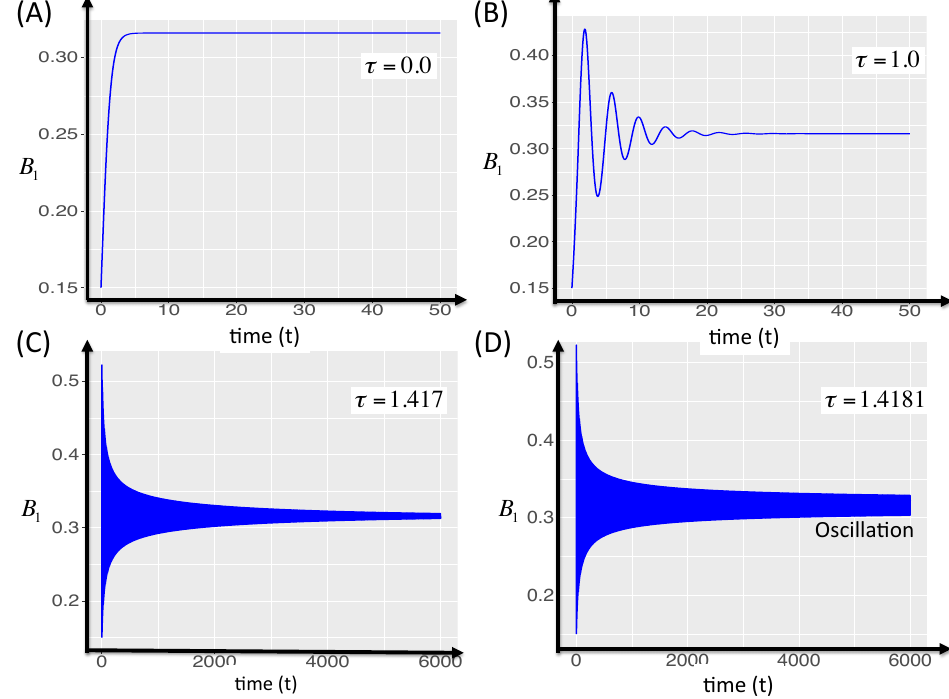
Figure 11. Characterization of the simpler delay differential equation (DDE) immune system (45). ( A – D ) Time courses of harmful bacteria population ( B 1 ) in the absence ( τ = 0.0 in (A)) and presence of different time delays ( τ = 1.0 in (B); τ = 1.417 in (C), and τ = 1.4181 in (D)). The stable